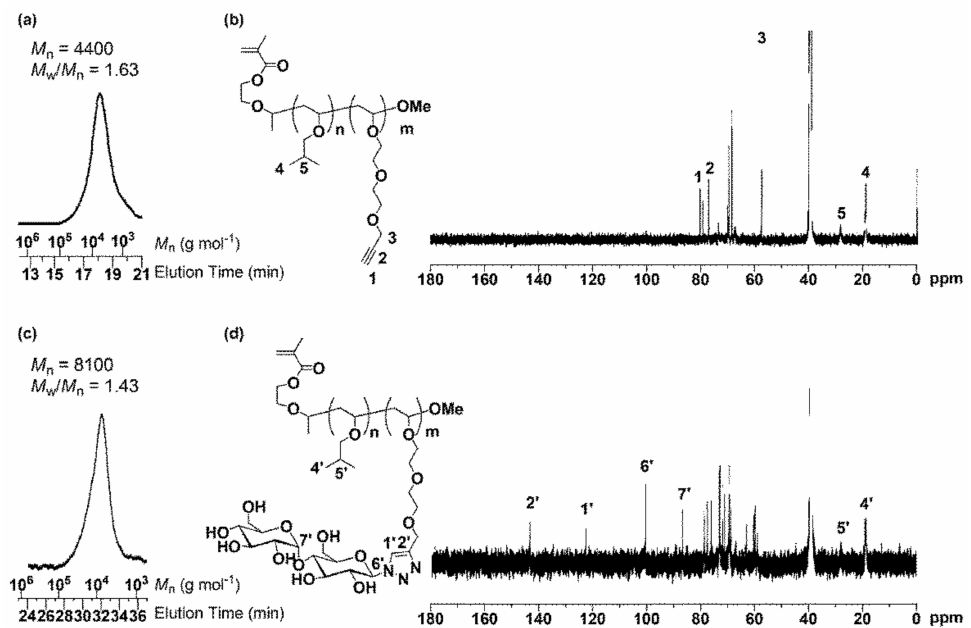
Figure 2. ( a ) Size exclusion chromatography (SEC) curve of MA-PIBVE 25 - b -PVEEP 10 using tetrahydrofuran (THF) as the eluent. ( b ) 13 C Nuclear magnetic resonance (NMR) spectrum of the MA-PIBVE 25 - b -PVEEP 10 macromonomer in CDCl 3 . ( c ) SEC curve of MA-PIBVE 25 - b -P(VE-Mal) 10 using 0.2 mol/L NaNO 3 (aq.) as the eluent. ( d ) 13 C NMR spectrum of MA-PIBVE 25 - b -P(VE-Mal) 10 macromonomer in DMSO- d 6